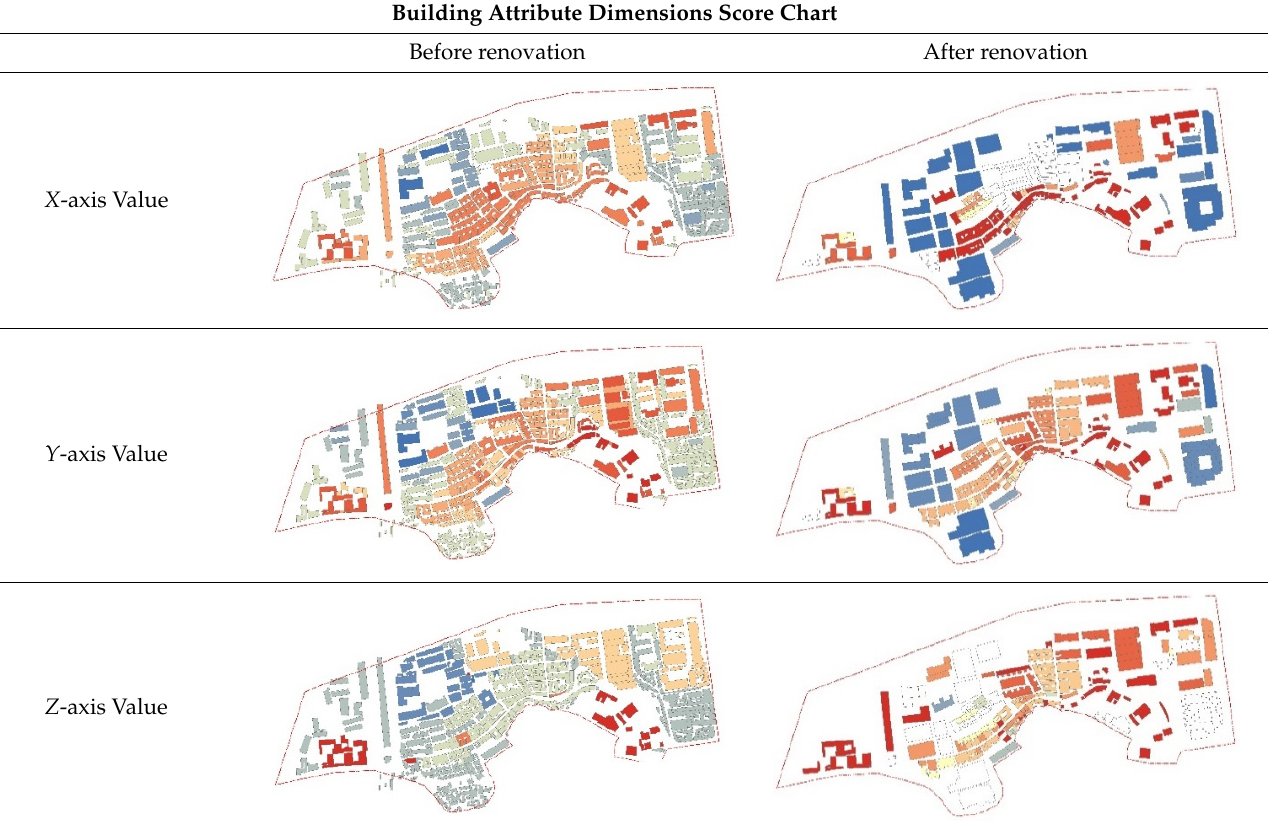
Figure 7. The research process in sustainable building attribute assessment model. Table 2. Building attribute dimensions score chart.